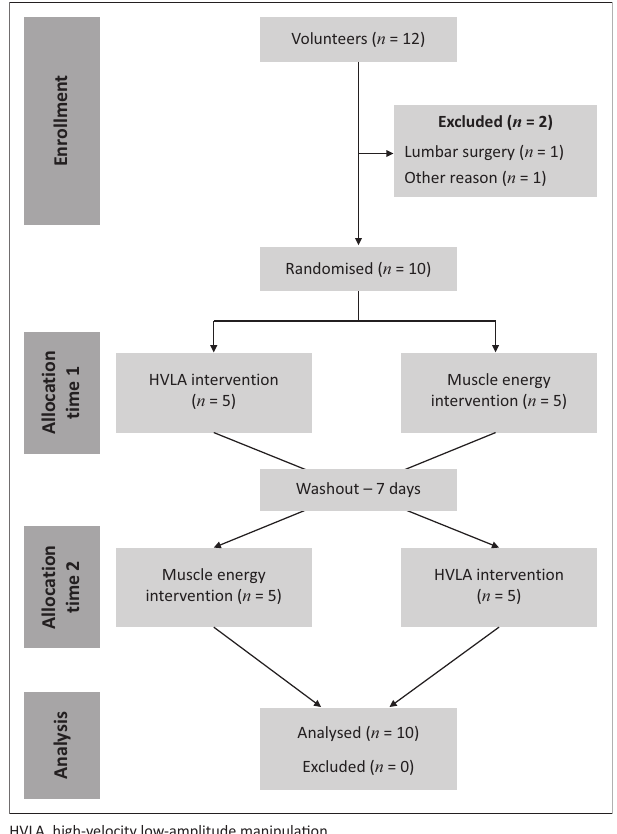
FIGURE 1: Flowchart – Consolidated Standards of Reporting Trials